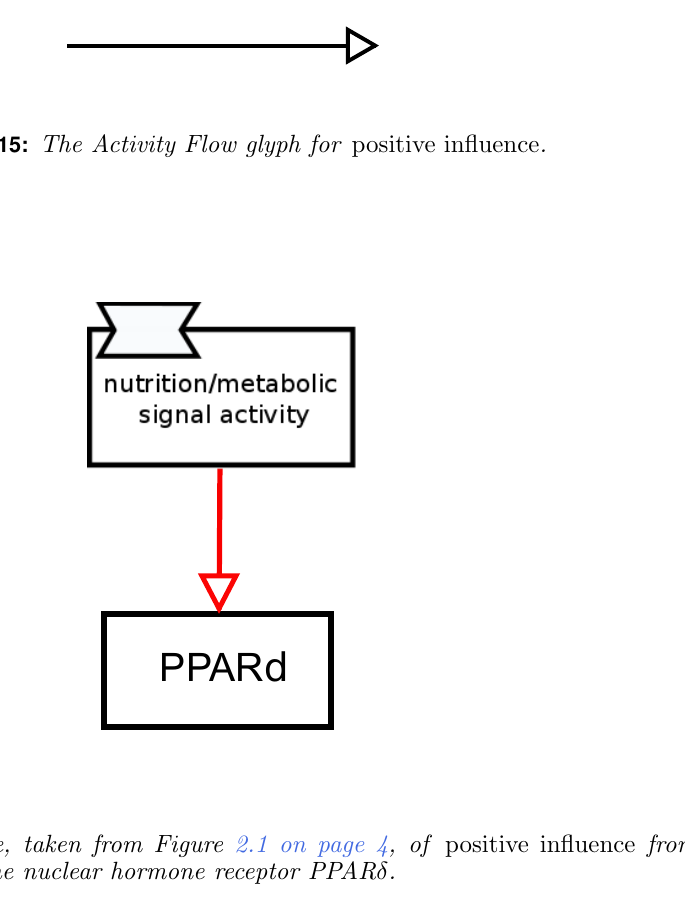
Figure 2.16: An example, taken from Figure 2.1 on page 4, of positive influence from a perturbation to the to the nuclear hormone receptor PPAR δ